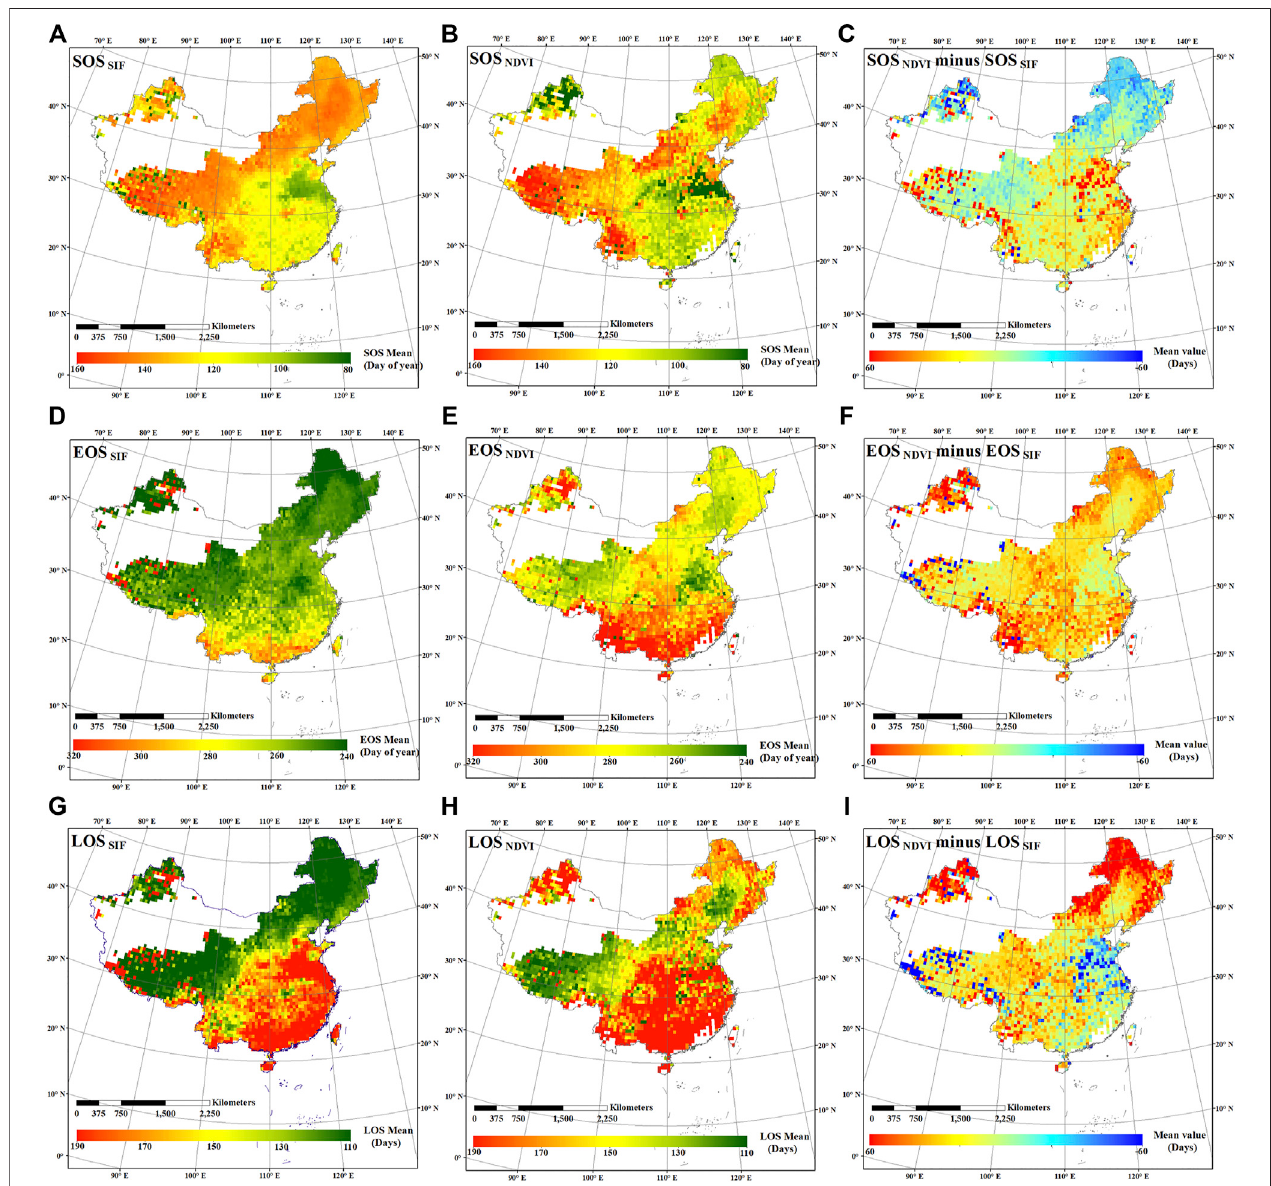
FIGURE 7 | Spatial distributions of 7-years averaged SIF and NDVI-based SOS (A, B) , EOS (D, E) , and LOS (G, H) dates, the difference between NDVI and SIF- based SOS (C) , EOS (F) , and LOS (I) dates in China during 2007 – 2013.